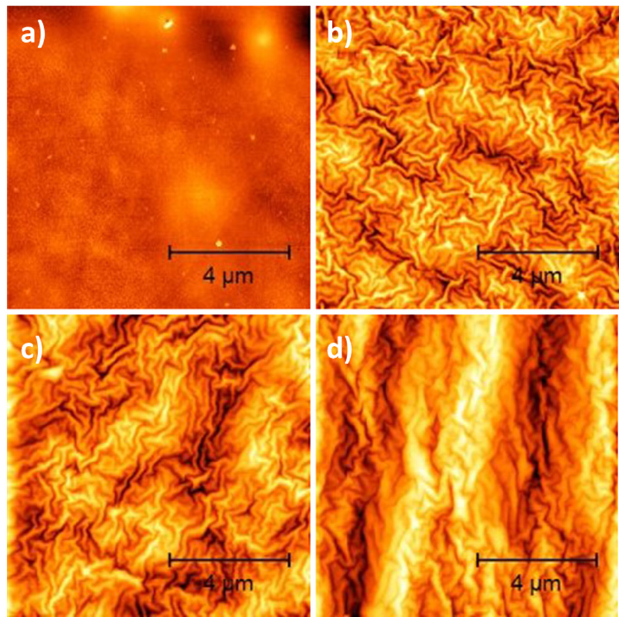
Figure 1. AFM images of ( a ) pristine PLA and ( b ) PLA/25 nm WO x , ( c ) PLA/50 nm WO x and ( d ) PLA/100 nm WO x .